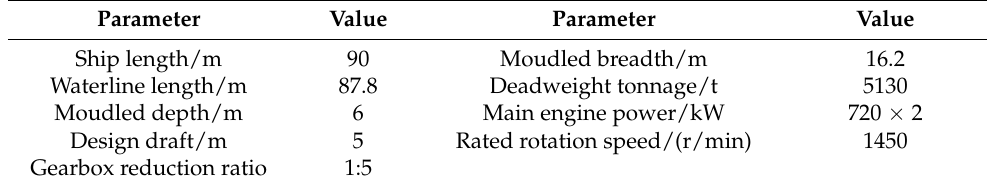
Figure 4. The inland bulk carrier on the Yangtze river. Table 1. Parameters of the target ship.